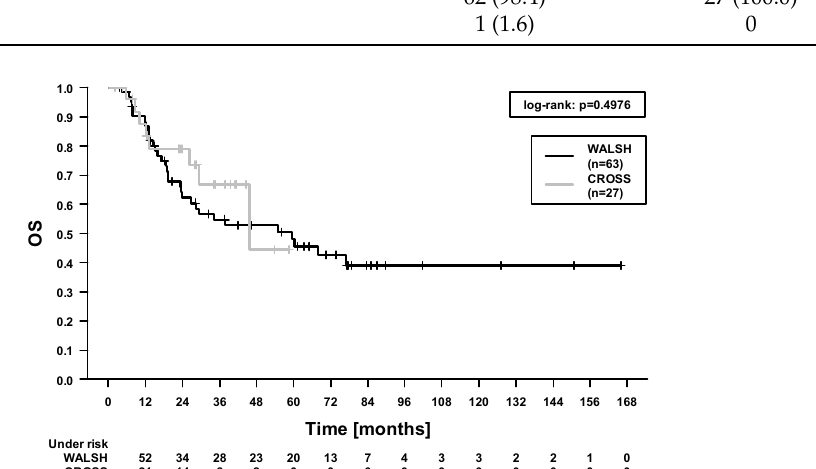
Figure 1. Overall survival (OS). Comparison between patients treated with carboplatin/paclitaxel (‘CROSS’) and patients treated with 5-fluorouracil/cisplatin (‘WALSH’).